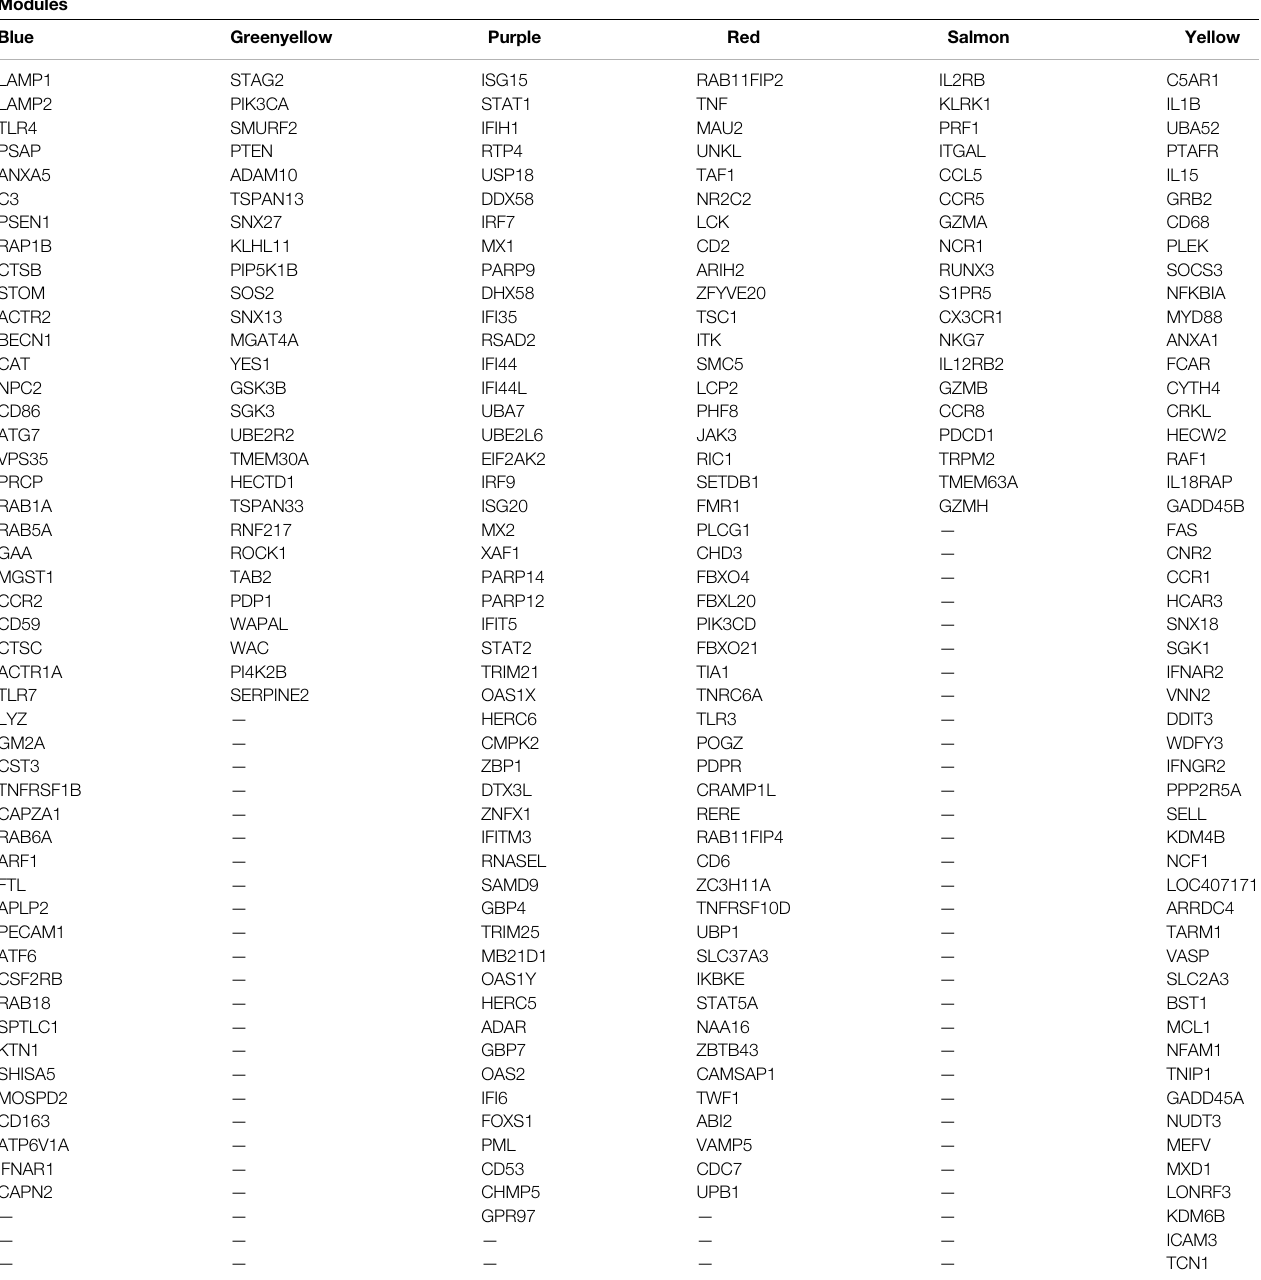
TABLE 2 | List of the hub – hub genes of the nonpreserved and biologically BRD-related modules that were identi fi ed by module preservation analysis.